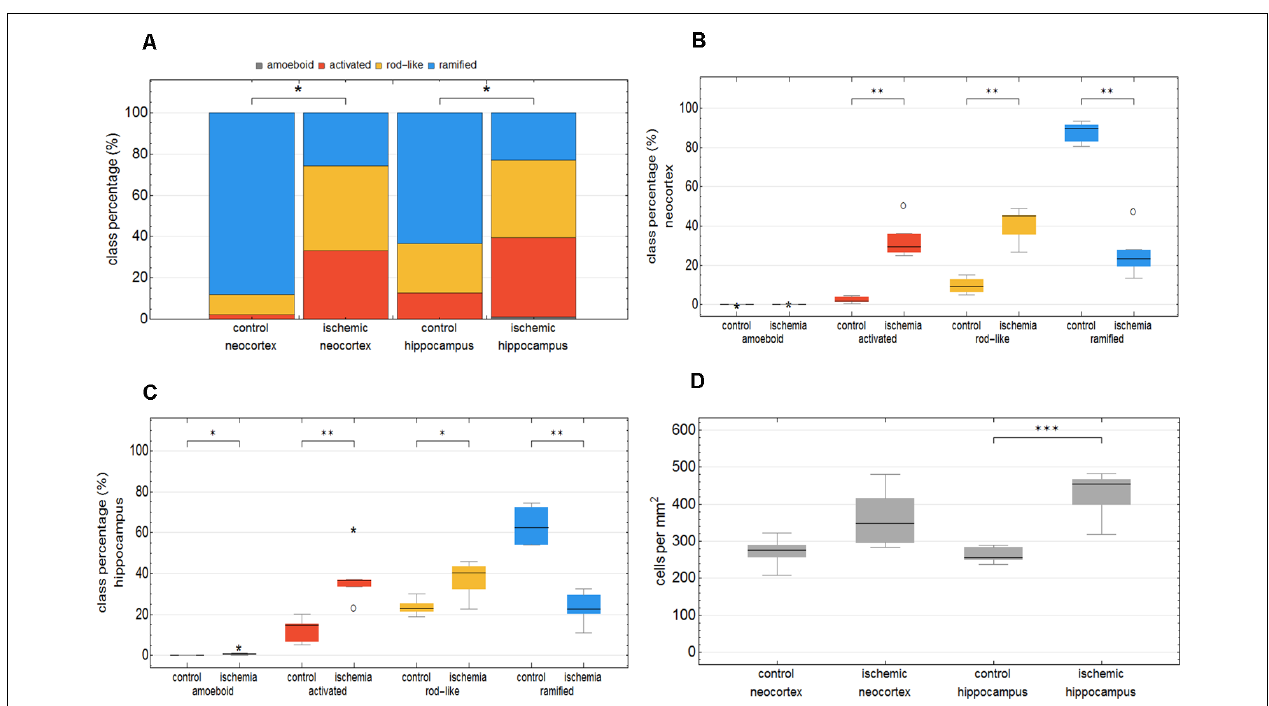
FIGURE 7 | Total class percentage of microglial morphological phenotypes in control and ischemia-affected regions. Class percentage of ramified, rod-like, activated, and amoeboid microglia within the control neocortex, ischemic neocortex, control hippocampus, and ischemic hippocampus (A) . Individual class percentage of the four microglial morphological phenotype classes in the neocortex (B) and in the hippocampus (C) . Normalized microglial cell density in control and ischemia-affected regions (D) . n = 6 animals and about 16,000 analyzed cells. *** p < 0.001; ** p < 0.01; * p <